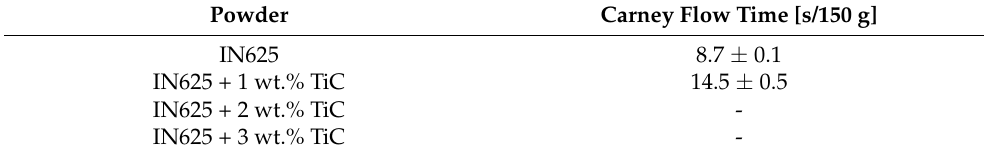
Table 2. Flowability of the IN625 and IN625/TiC powder determined by the Carney flow test.